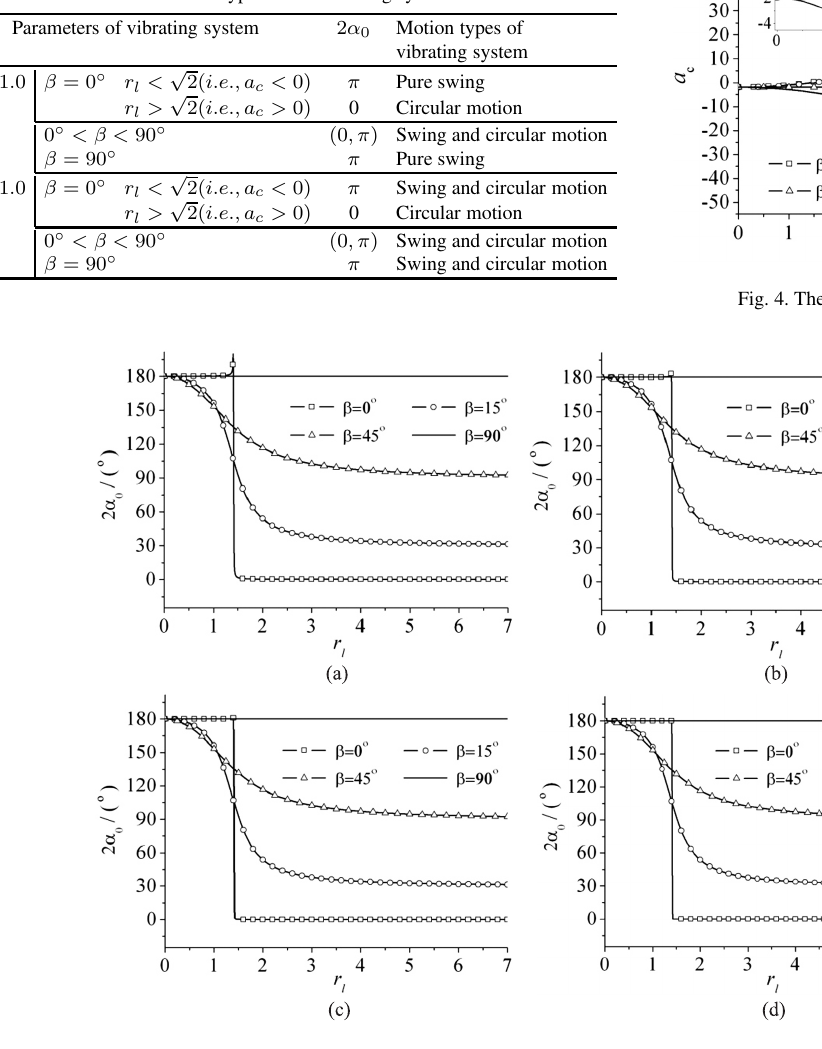
Fig. 5. Approximate values of 2 α 0 with the two identical motors: (a) η = 0 . 2 ; (b) η = 0 . 5 ; (c) η = 0 . 8 ; (d) η = 1 . 0